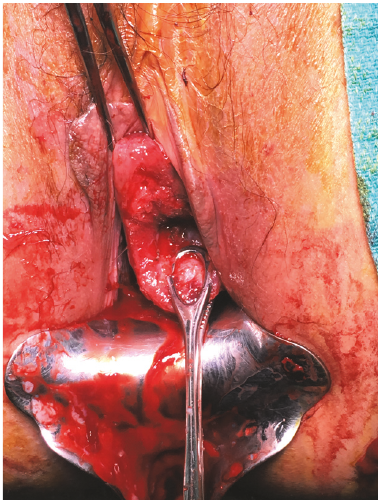
Figure 2: Cervix postmyomectomy with cauterized fibroid stalk base. Ring forceps on posterior lip of cervix and single-toothed tenaculum on anterior surface of